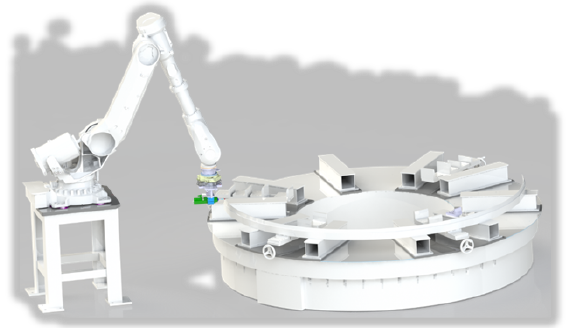
Figure 11. The robotic milling system.